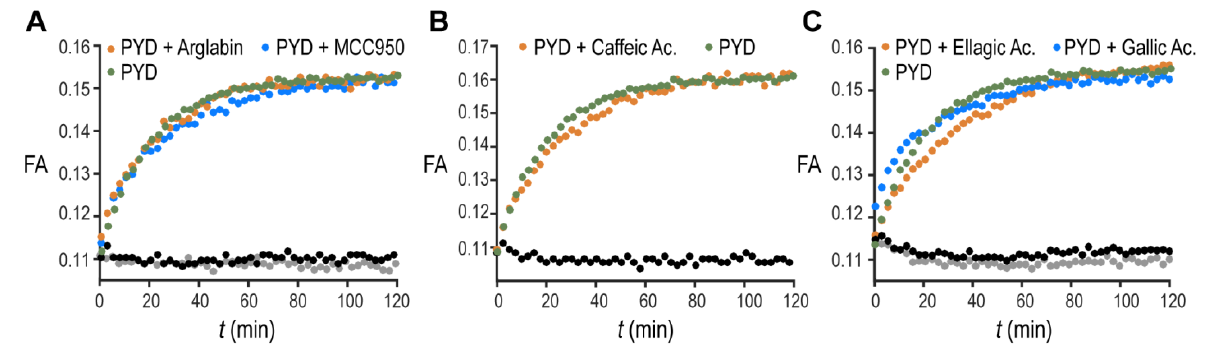
FIGURE 3: Inability of five small molecules to inhibit PYD filament formation. (A-C) Time-dependent fluorescence anisotropy (FA) meas- urements after pH jump on PYD only solution (dark green) and on PYD solution premixed with 20 µM final concentration of (A) Arglabin (orange) or MCC950 (light blue), (B) Caffeic acid phenethyl ester (orange), (C) Ellagic acid (orange) or Gallic acid (light blue). Time- dependent fluorescence anisotropy (FA) measurements for PYD incubated with compounds without pH jump are shown (black, gray). Data are reported in 3 min intervals for a total time of 120